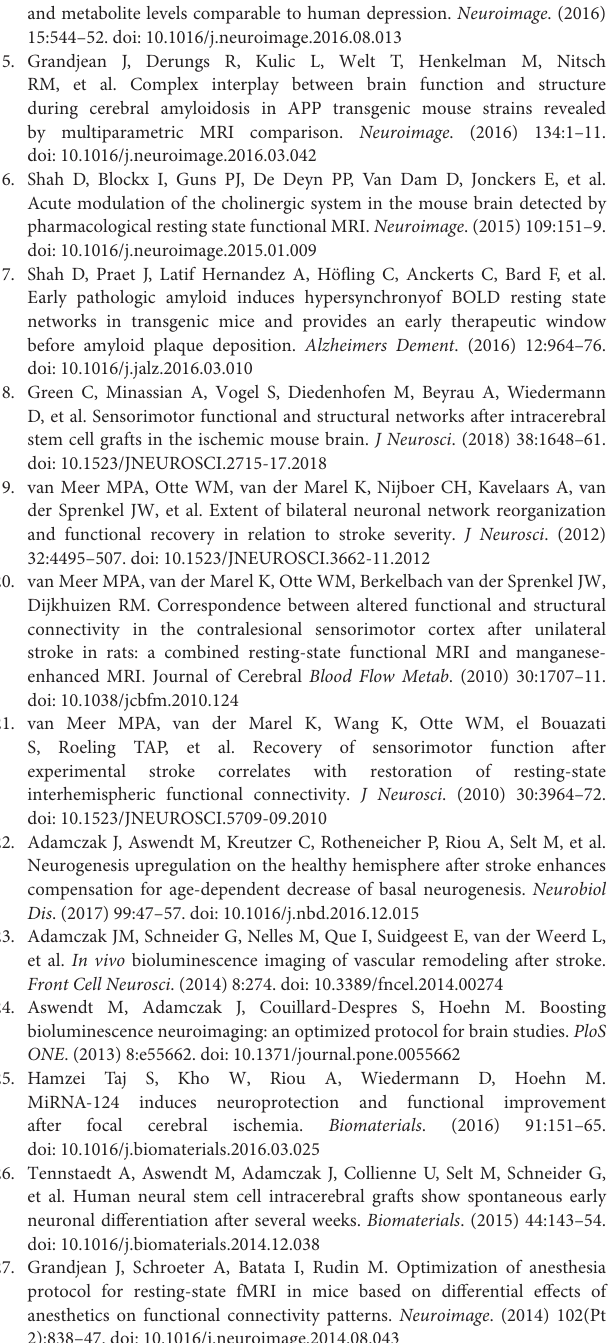
changes are overlaid on coronal RARE MR images of a representative healthy mouse brain. This was achieved by co-registration of the mouse brain atlas with the MRI mouse brain template which again was co-registered with the individual RARE MRI data set. This procedure is described in detail in the Methods section. The four coronal images presented here cover the range of the mouse brain for all relevant sensorimotor cortex areas and the thalamus, at the rostral-caudal axis, equidistantly from − 1.55mm to + 1.05mm relative to